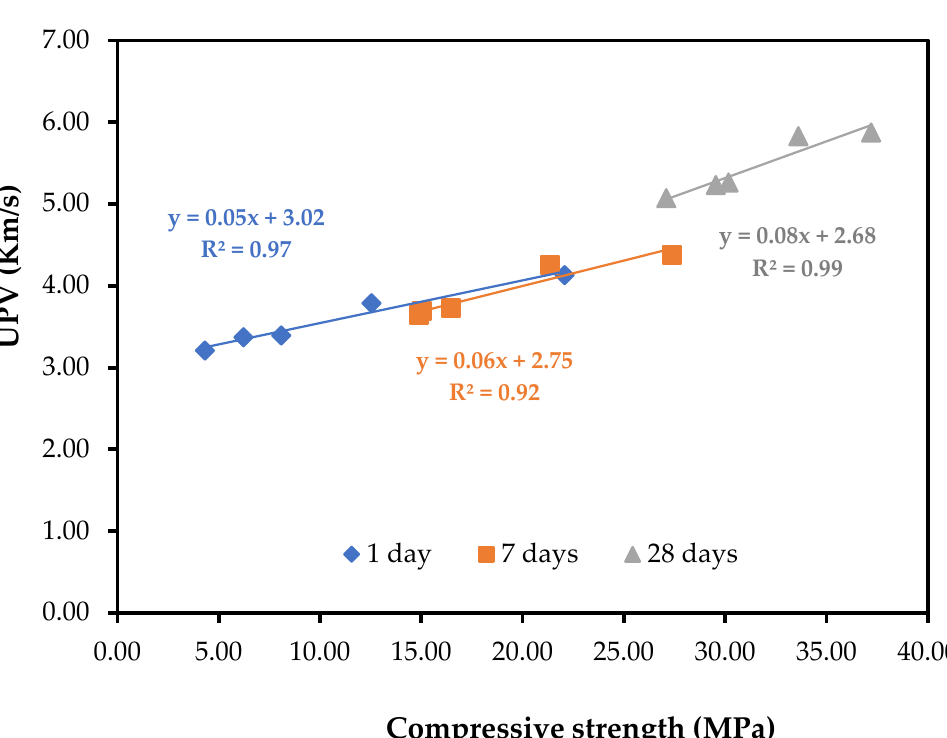
Figure 8. Compressive strength for cubes with powder glass and PA fi bers (6 cubes/mix).